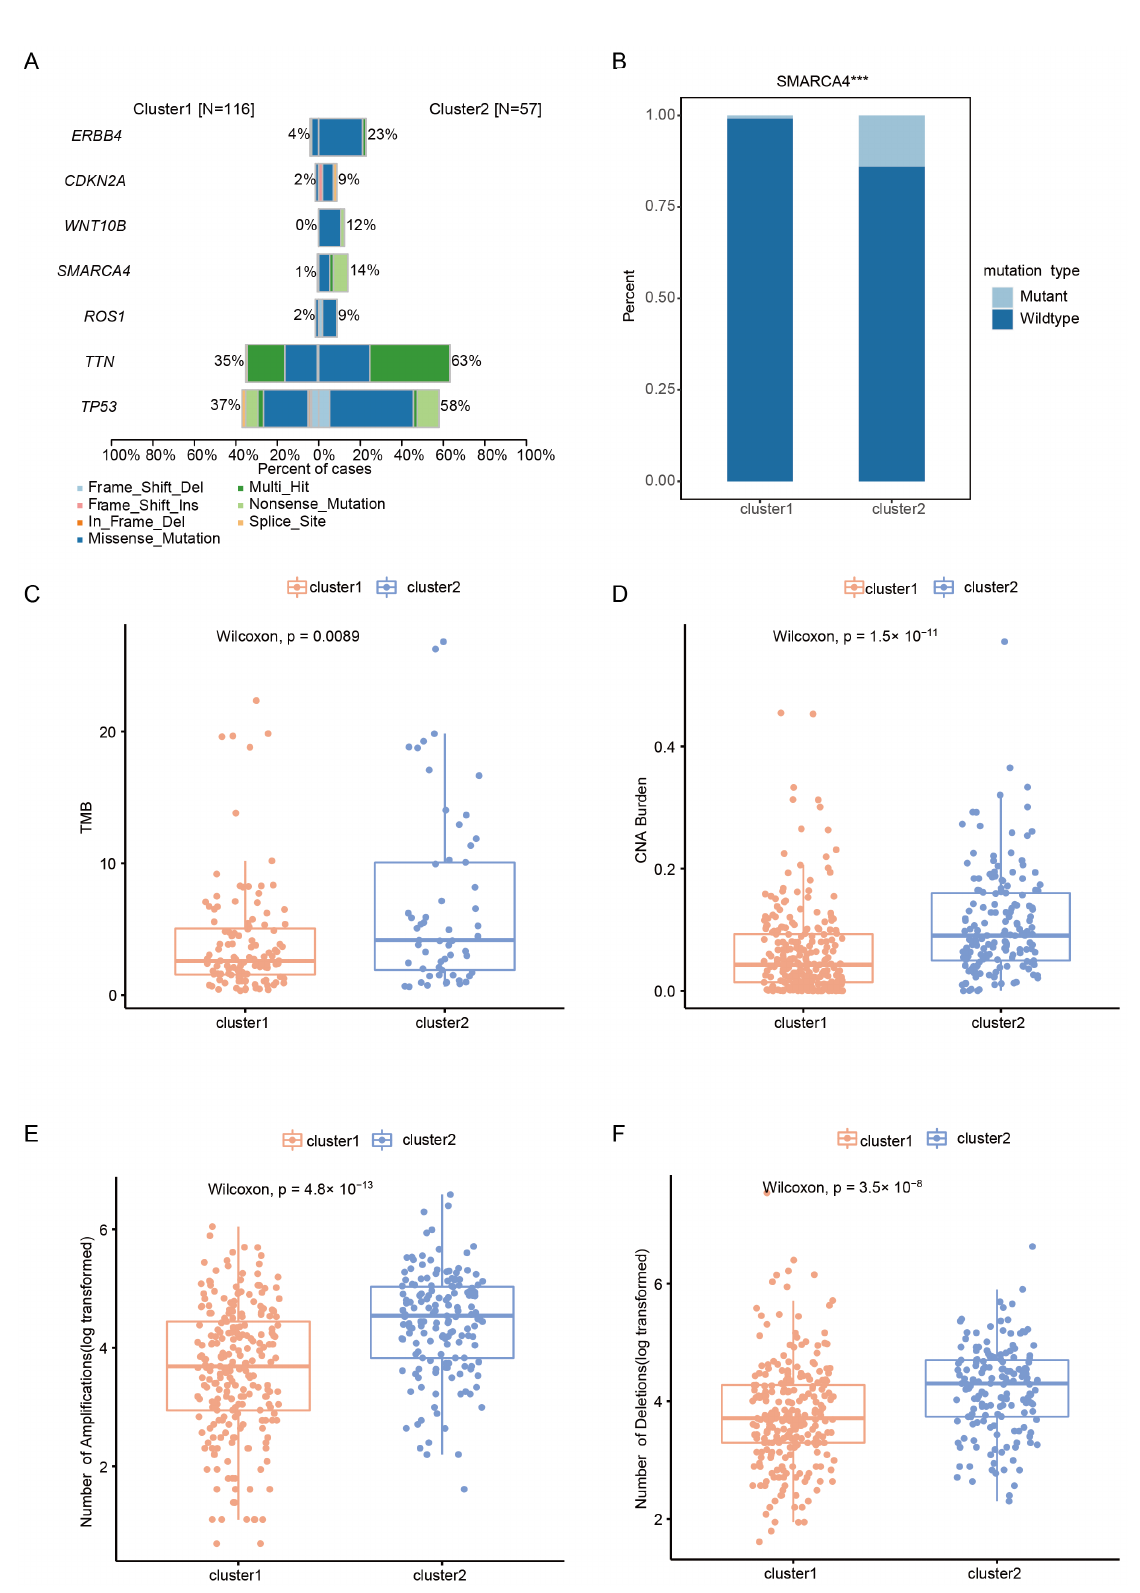
Figure 3. Somatic variations of the m6A/m5C clusters. ( A ) Barplots showing the seven differential mutated genes of clusters. ( B ) Bar plots showing the mutation frequency of SMARCA4 in the clusters. ( C ) Comparisons of TMB between two clusters. ( D ) Comparisons of the CNA burden between two clusters. ( E ) Comparisons of the number of amplifications between two clusters. ( F ) Comparisons of the number of deletions between two clusters. ***, p <